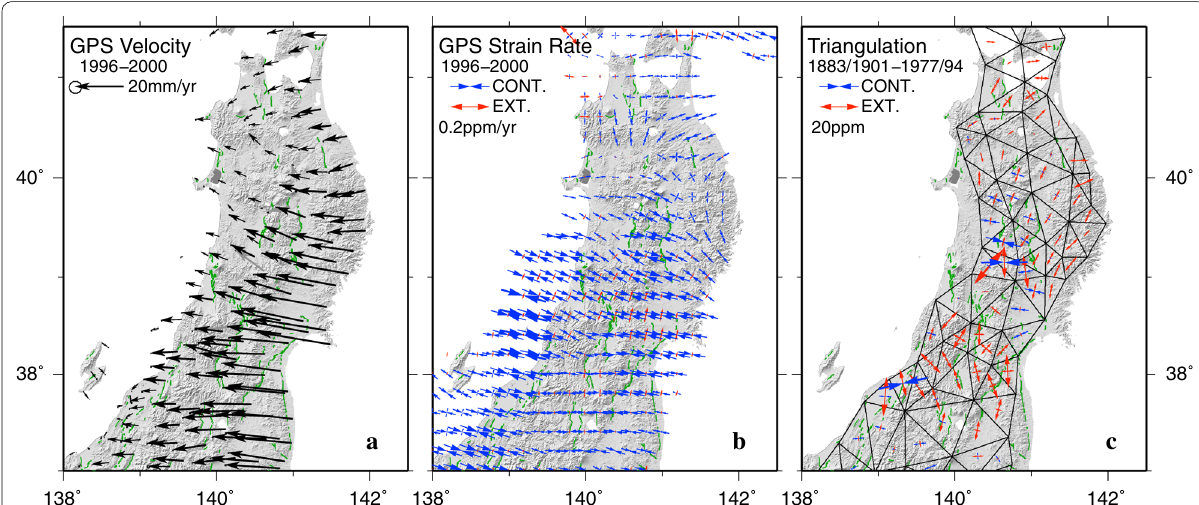
Fig. 1 Geodetic data in the Tohoku area. a GPS velocity during 1996–2000. Reference point is Oogata (950241) along the Japan Sea coast of the southwestern end of the plot. Green lines show the active fault traces. Gray velocity arrows are removed for the strain rate calculation because of local disturbances. b Strain rate distribution calculated from GPS velocity using the method of Shen et al. (1996). c Strain distribution from repeated triangulation